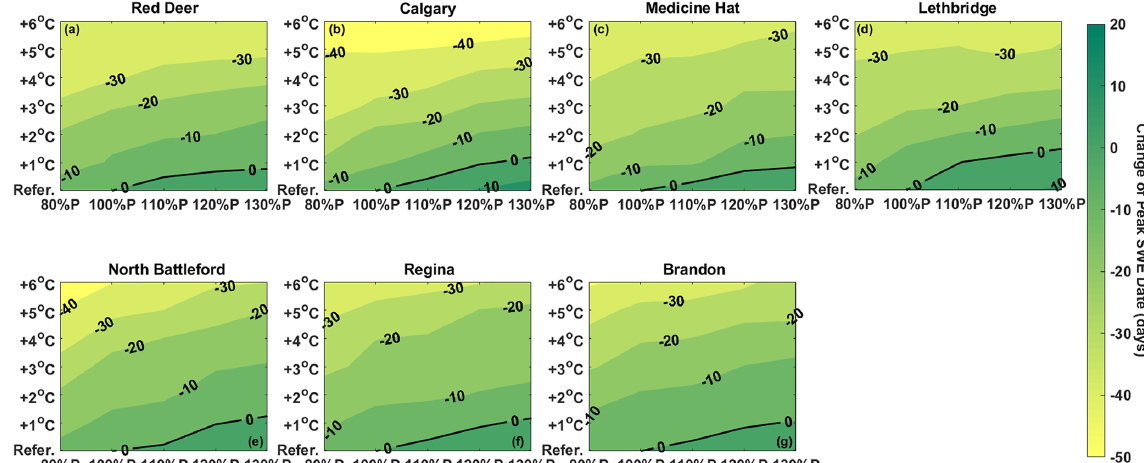
Figure 7. Change in peak annual snow water equivalent date at the wetland HRU under warming and changes in precipitation for simulations using the perturbed 30-year climate data. Negative signs in the peak SWE date plot represent advances in time and positive signs and denote a delay in the date of peak SWE accumulation.